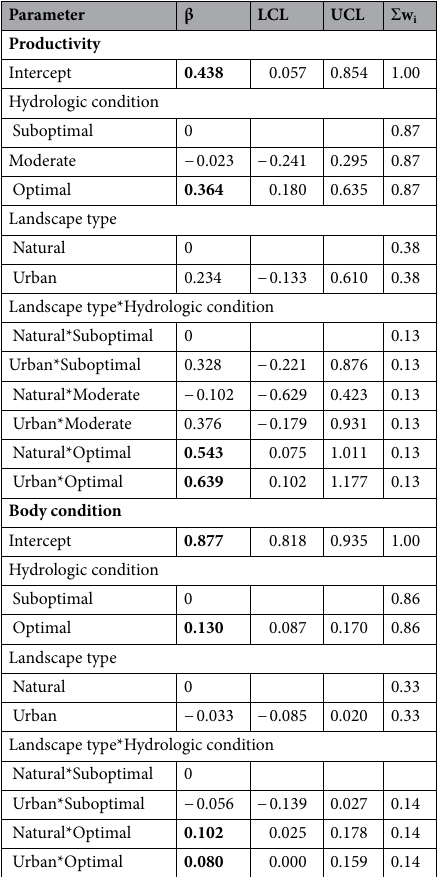
Table 2. Model averaged parameter estimates (β) for all models < 4 ∆AIC c from the top model, 95% confidence limits (LCL, UCL), and variable importance values ( Ʃ w i ) for models predicting productivity and body condition, 2015–2017, South Florida. Bolded parameter estimate values indicate a parameter estimate where confidence intervals did not overlap